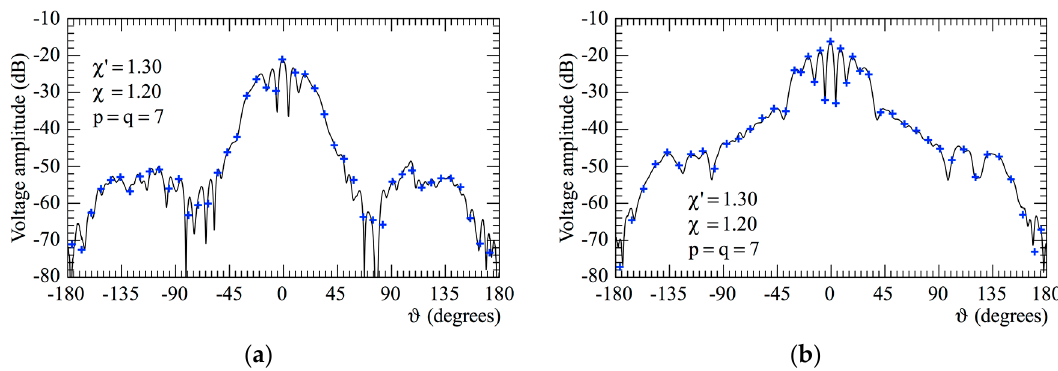
Figure 9. Amplitude of p V and r V on the meridian at ϕ = 30°. ――― reference + + + + interpolated from the non-redundant measurements: ( a ) p V ; ( b ) r V .